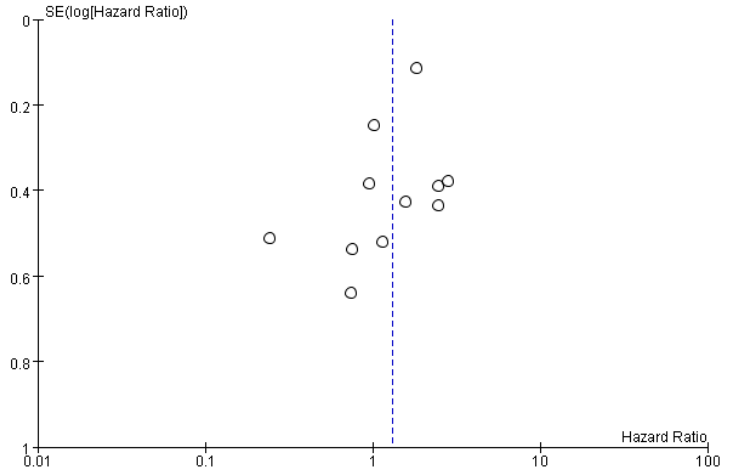
Figure 6. Funnel plot analysis demonstrating no publication bias.